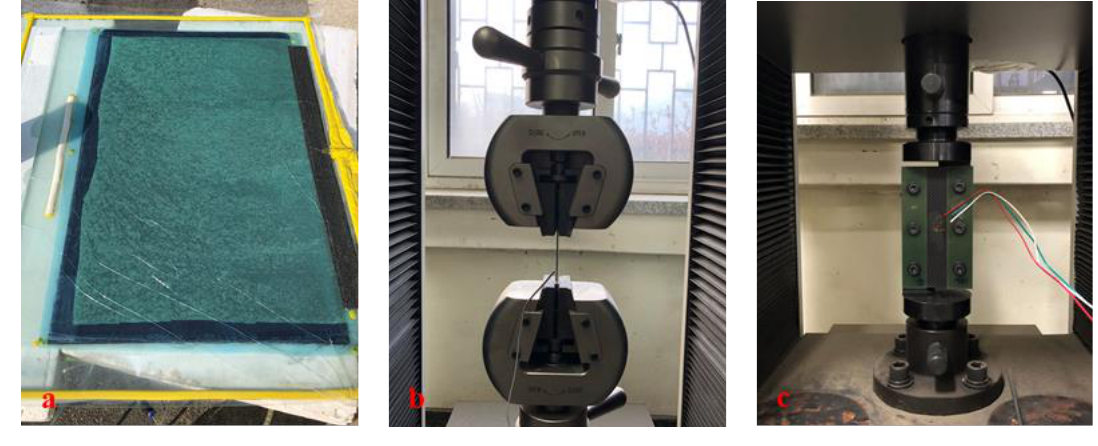
Figure 1: (a) vacuum infusion process, (b) tensile testing and (c) shear testing